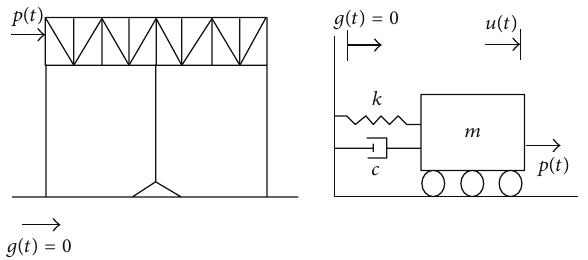
Figure4:Asingledegree-of-freedomsystemforone-storybuilding.